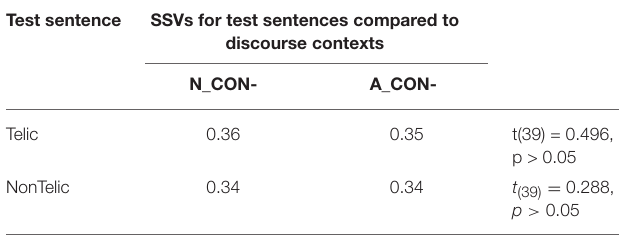
TABLE 4 | Semantic Similarity Values (SSVs) for the test sentence and the discourse context. Test sentence